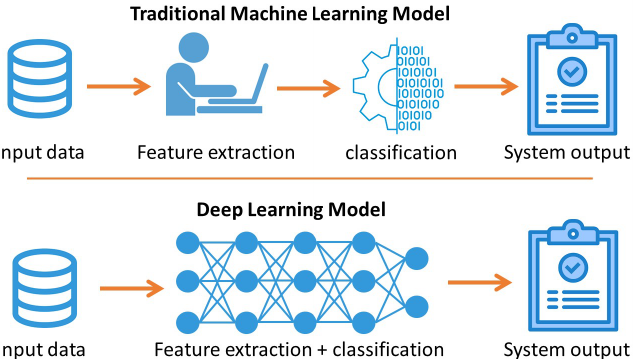
Figure 7. A comparison of deep learning and traditional machine learning